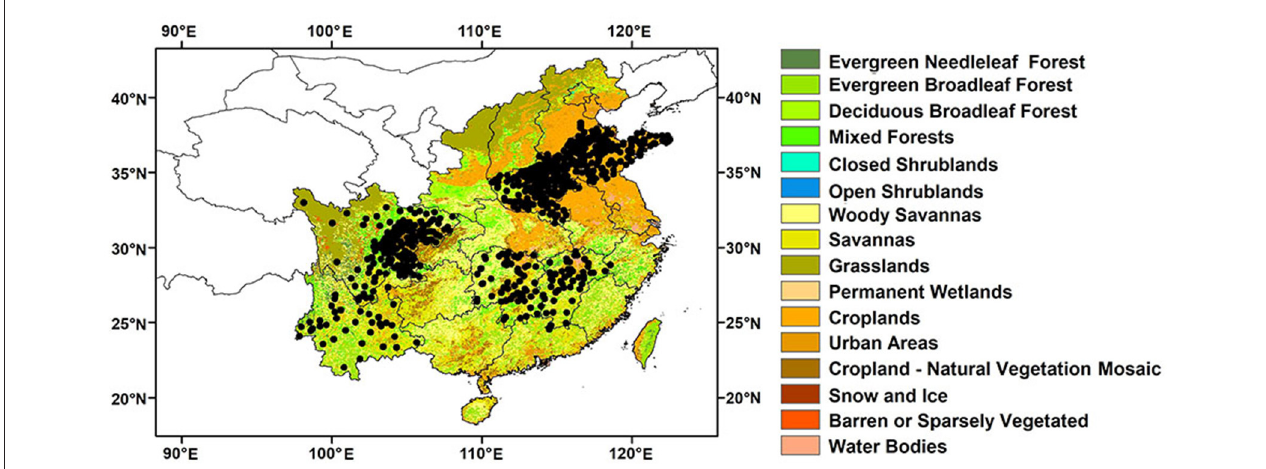
FIGURE 1 | Locations of the 596 in situ SM sites in the southeast of China. The background map is the MODIS IGBP data set.